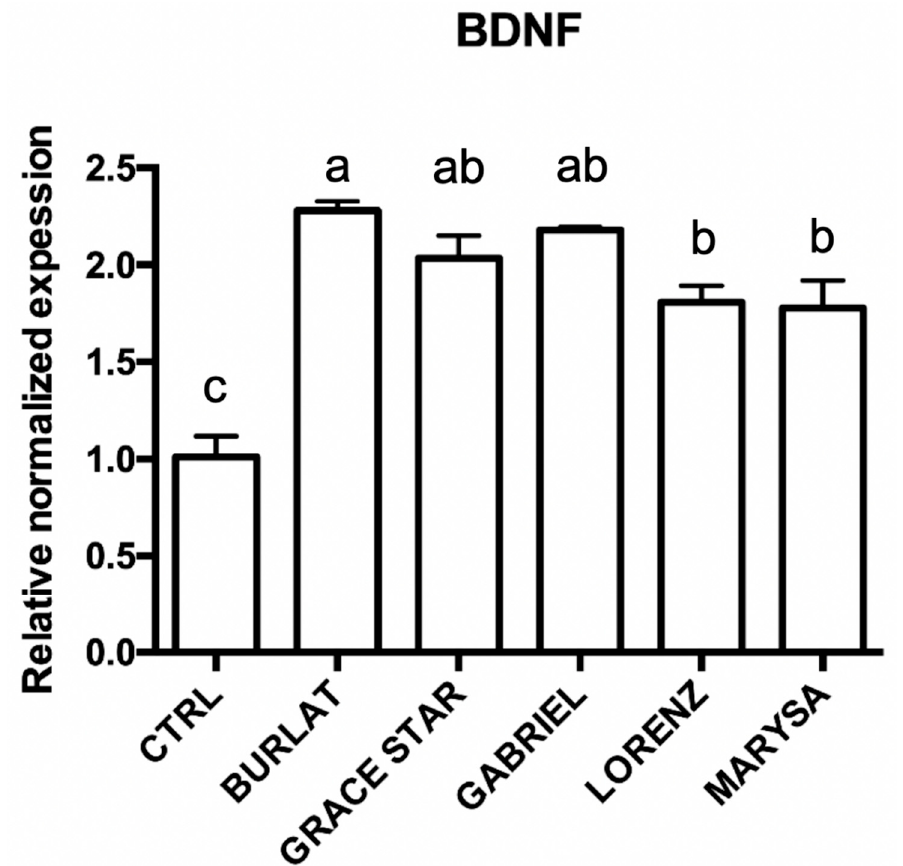
Figure 9. E ff ect of cherry extracts on the expression of brain-derived neurotrophic factor (BDNF) in SH-SY5Y cells. Each bar represents the mean ± SEM of at least three independent experiments. Di ff erent letters indicate statistical significance ( p < 0.05).